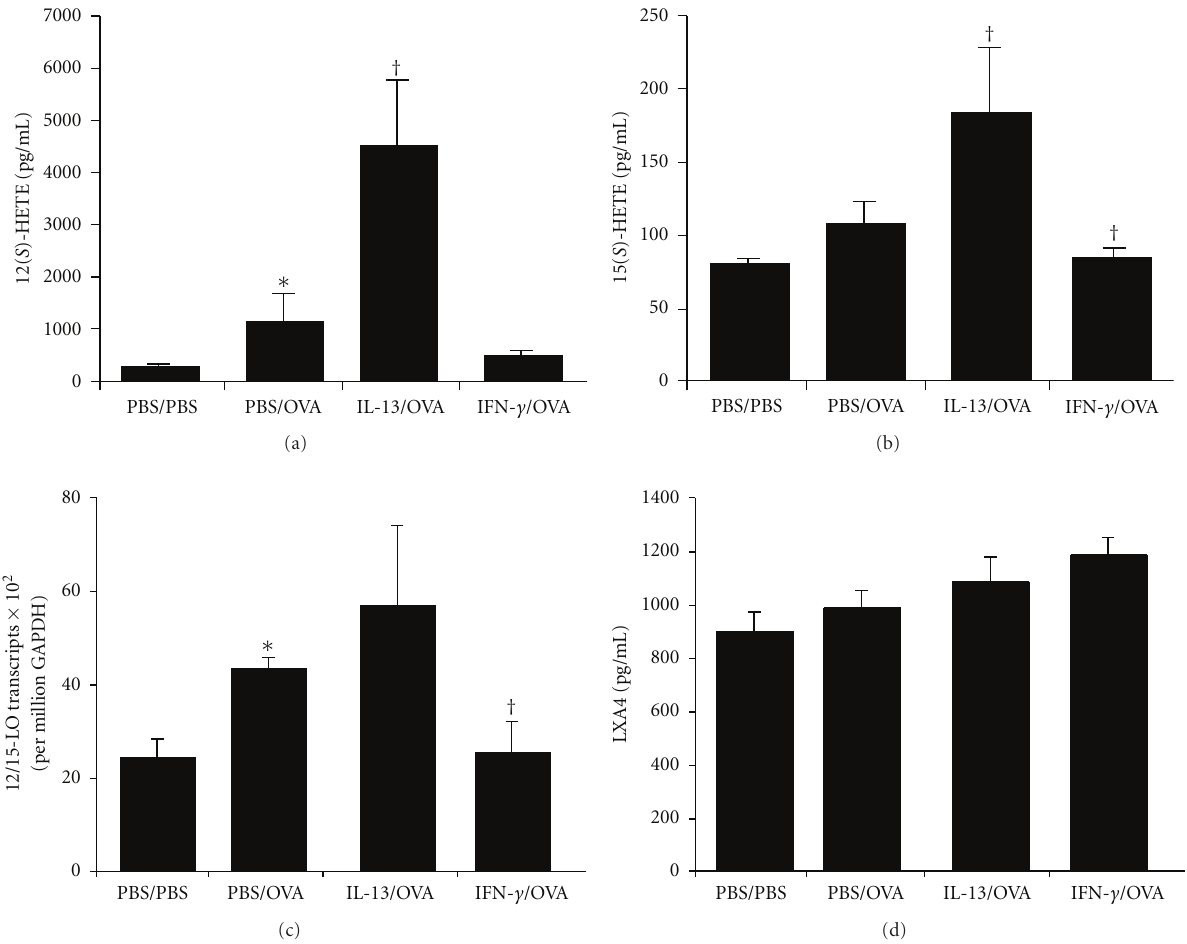
Figure 2: E ff ects of IL-13 and IFN- γ on 12/15-LO. Levels of 12( S )-HETE (a) and 15( S )-HETE (b) and LXA4 (c) in BALF and 12/15-LO transcripts in whole lung (d) from PBS/PBS, PBS/OVA, IL-13/OVA and IFN- γ /OVA groups of mice. ∗ P -value ≤ . 05 versus PBS/PBS. † P - value ≤ . 05 versus